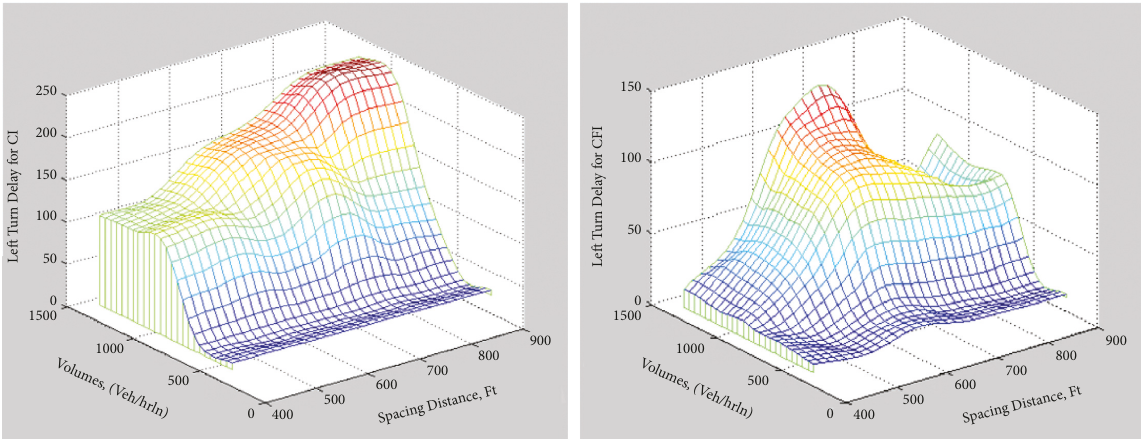
Figure 5: Left-turn delay for CI and CFI for various spacing distances. Select spacing distance (e.g., 900 ft.)